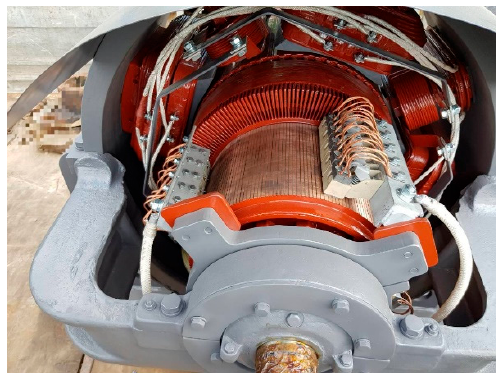
Figure 1. Photo of 4GPEM-220 DC generator in a factory.